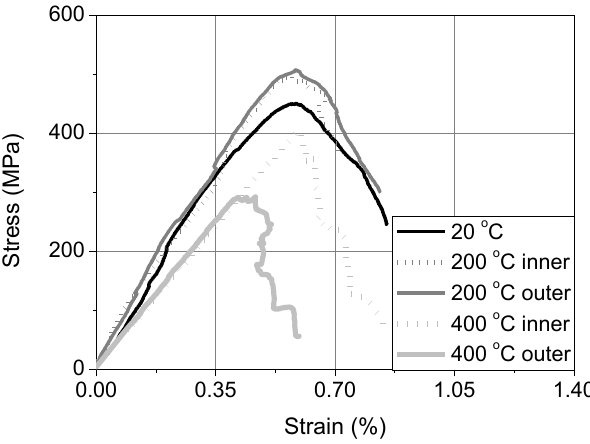
Figure 6. The representative curves of axial stress versus the strain of textile strips under tension.